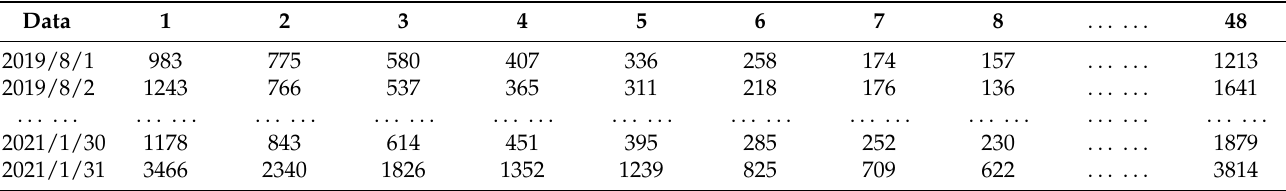
Table 2. Online Car-hailing Order Data After